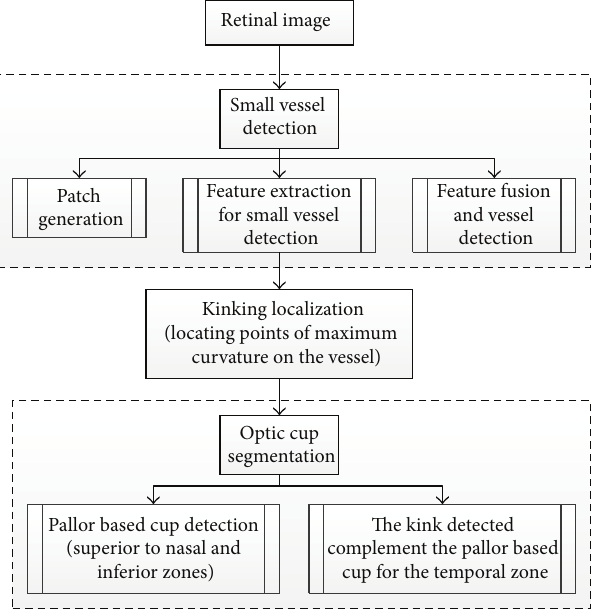
Figure 25: Flowchart for algorithm proposed in